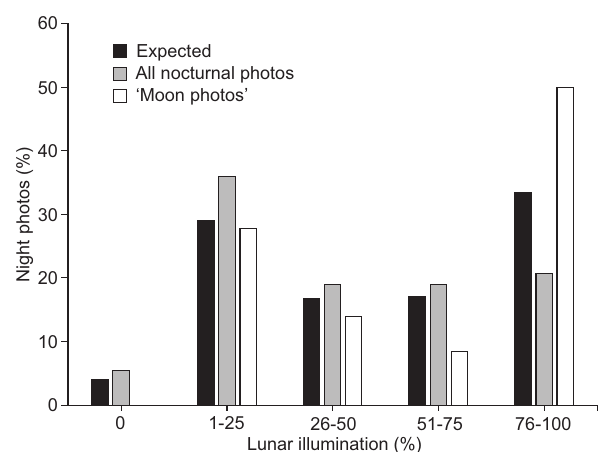
Figure 4. Distribution of photos of Cuniculus paca as a function of degree of lunar illumination. Expected proportion of photos, all nocturnal photos (n = 111), and ‘moon photos’ (n = 36) are